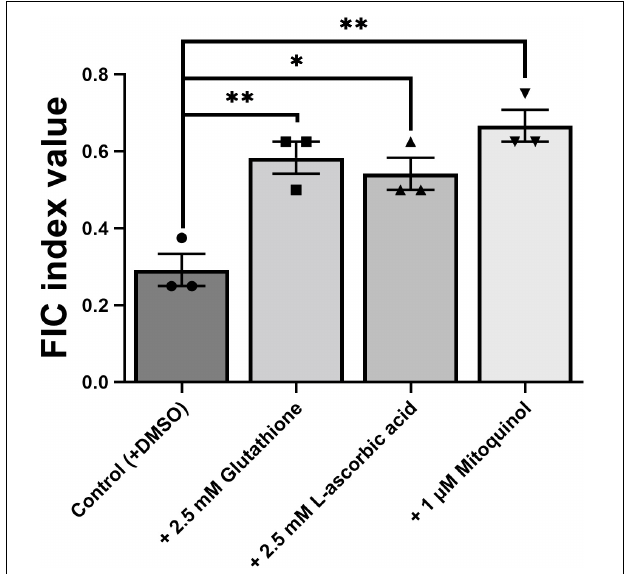
FIGURE 6 | Effect of antioxidants on the eugenol plus berberine synergy. Values plotted to represent mean FICI values from three independent checkerboard experiments performed with S. cerevisiae W303, as described in Figures 1 , 4 , with the inclusion of the antioxidants at the specified concentrations. Bar heights show means ± SEM. ∗ p < 0.05 and ∗∗ p < 0.05, according to unpaired t -tests. The relevant checkerboard data are presented in Supplementary Figure 6